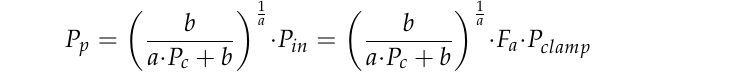
Figure 4. System simplified circuit diagram. 2.2.2. Power Supply Circuit Design The power supply circuit module is the basic unit of the sensor, supplying power to each module and ensuring the effective operation of each module. Since the power supply is a 12 V lithium battery, the LoRa communication circuit requires a 5 V power supply, and the STM32 processor and core circuit, sensor module, and SD card all require a 3.3 V power supply; therefore, the input power supply needs to be stepped down. In Figure 5,